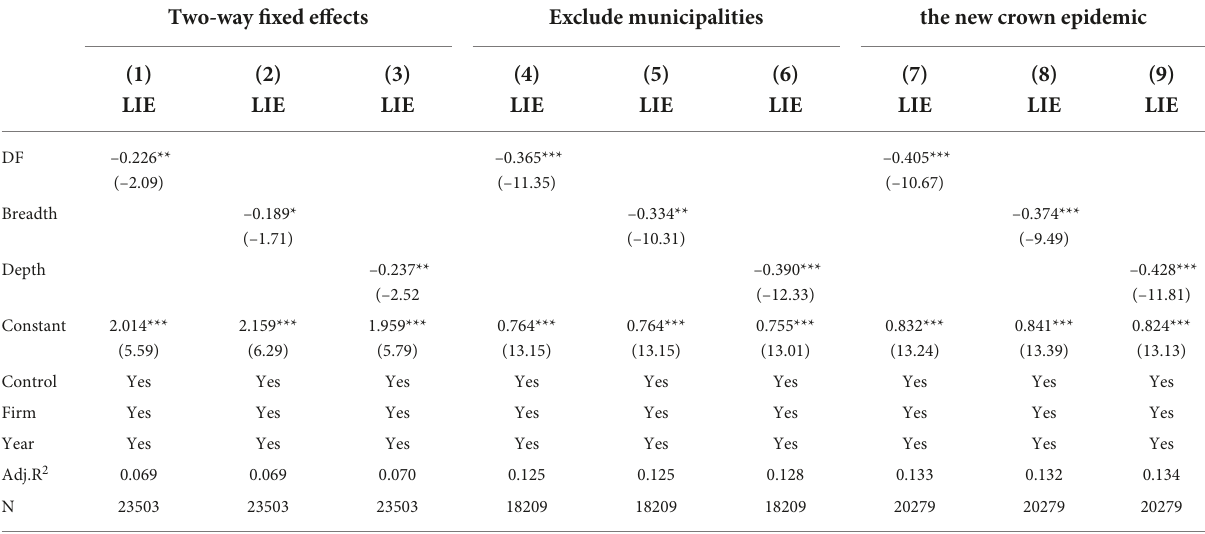
TABLE 9 Other robustness